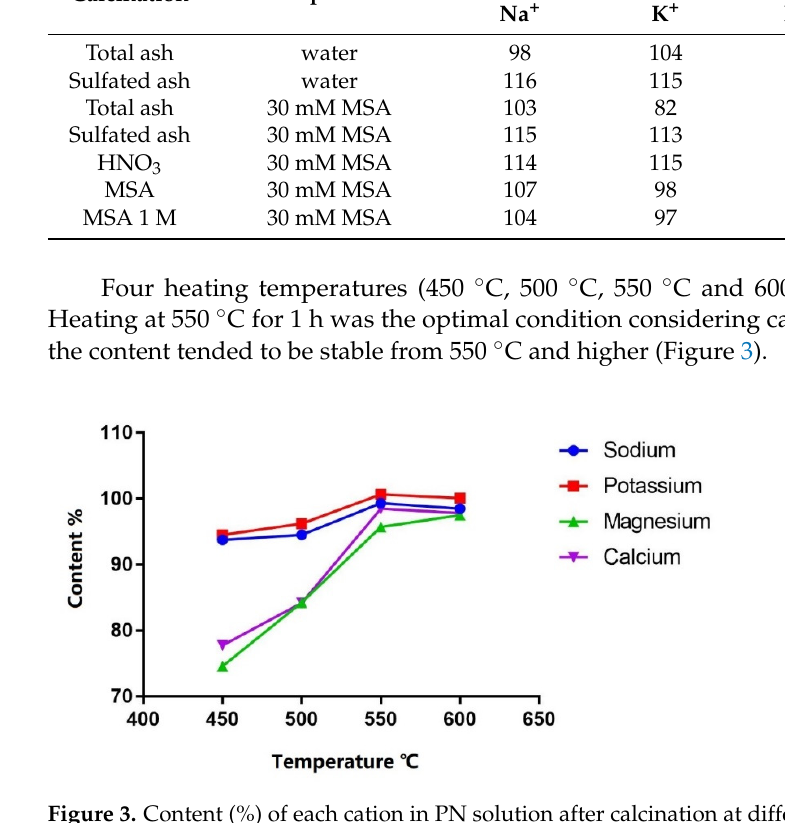
Figure 3. Content (%) of each cation in PN solution after calcination at different temperatures.